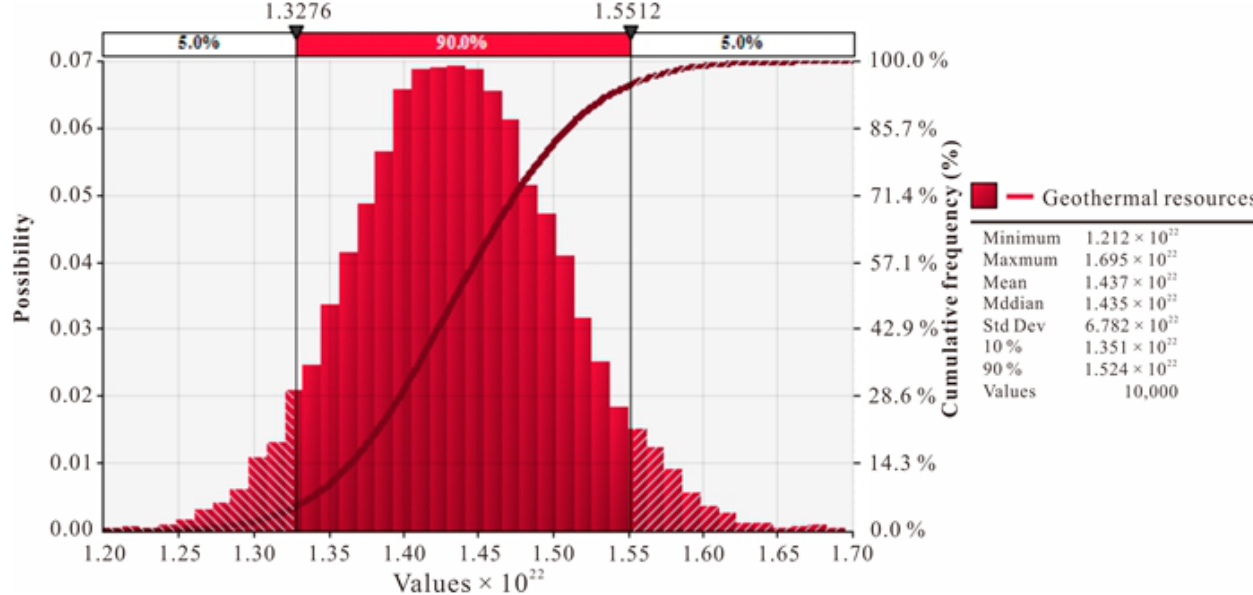
Figure 7. Geothermal resource potential simulation results for the sum of the four thermal reservoirs.